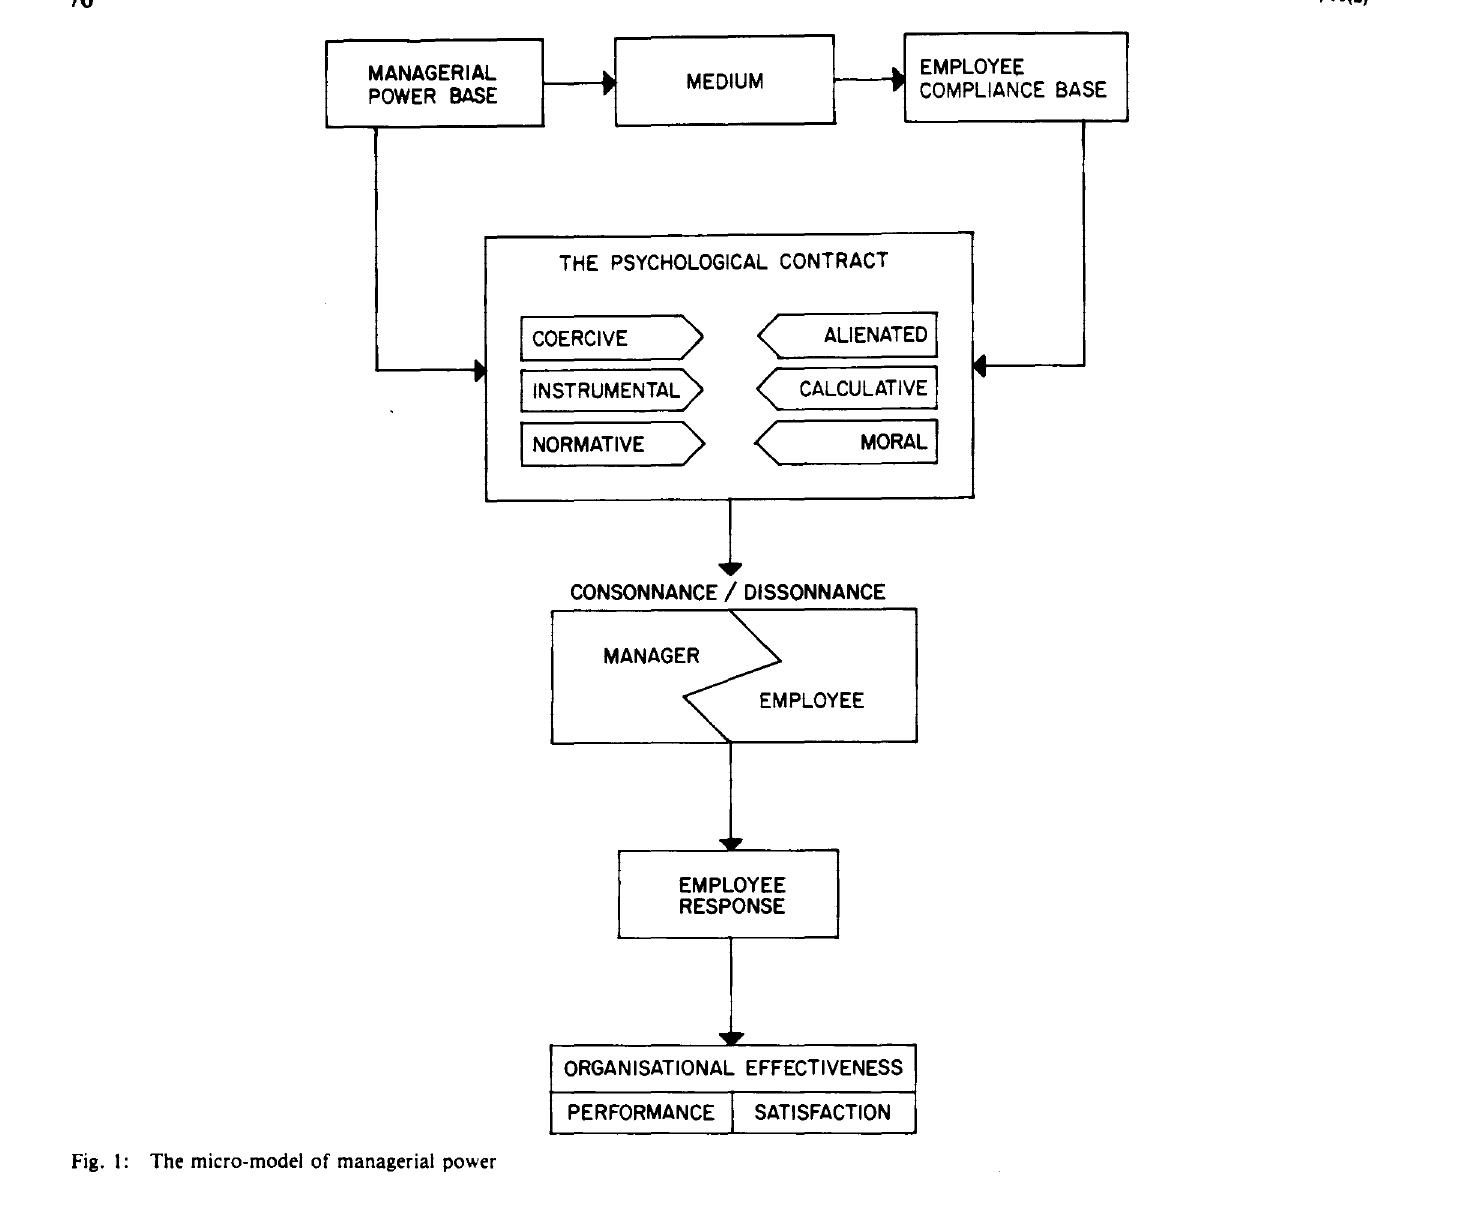
to take note of the usefulness of the concept in analysing the nature of power at the